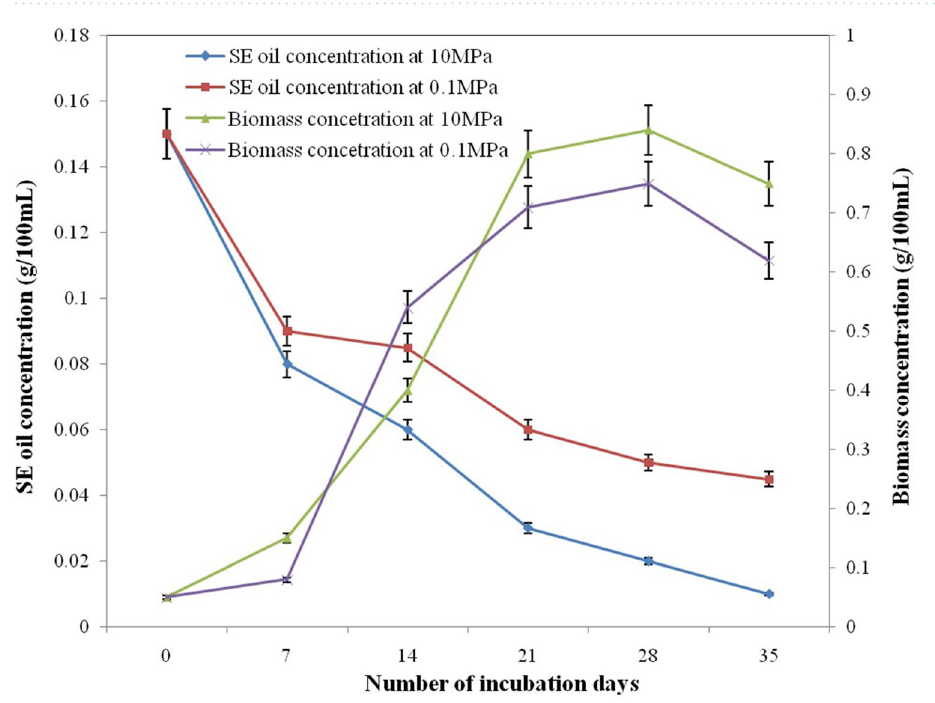
Figure 2. A. sydowii BOBA1 at different incubation time under 0.1 MPa and 10 MPa culture pressure